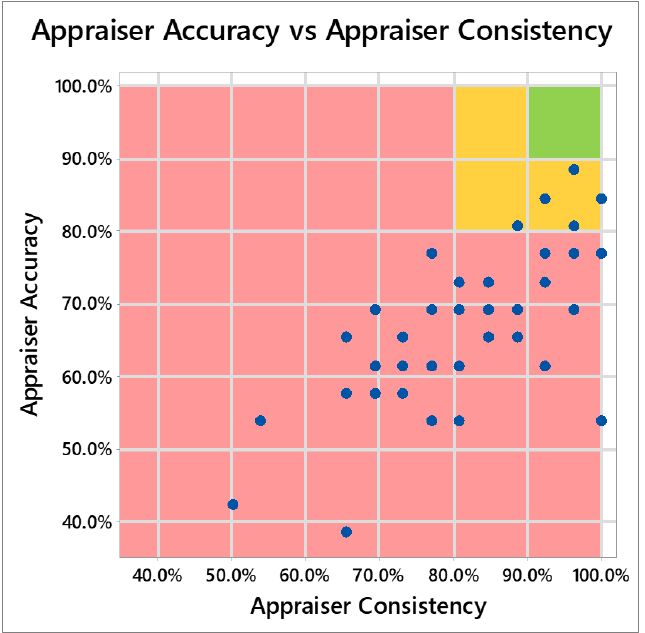
Figure 8. Appraiser Accuracy vs. Appraiser Consistency with agreement limits. Data for static images only, without the usual ability to view the blade from different perspectives and tactile feeling of the blade.